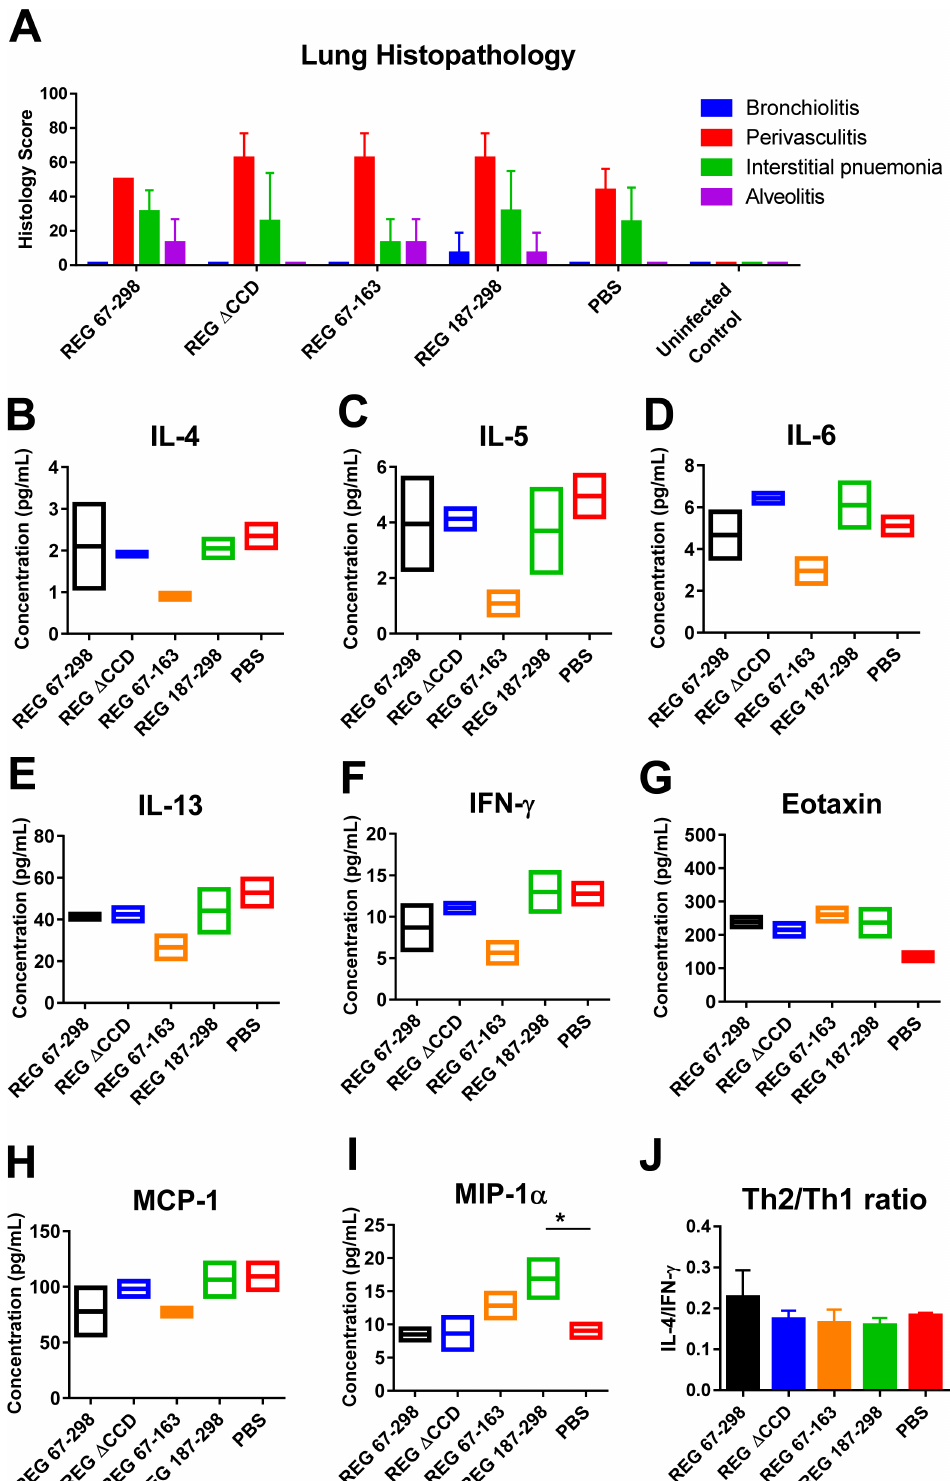
Fig 3. Histopathology and cytokine/chemokine levels in the lungs of animals vaccinated with the REG 67–298, REG Δ CCD, REG 67–163, and REG 187–298 at day 5 following RSV challenge. (A) Lung tissues were collected at 5 days post-challenge and were stained with hematoxylin and eosin. Individual lungs were scored for pulmonary